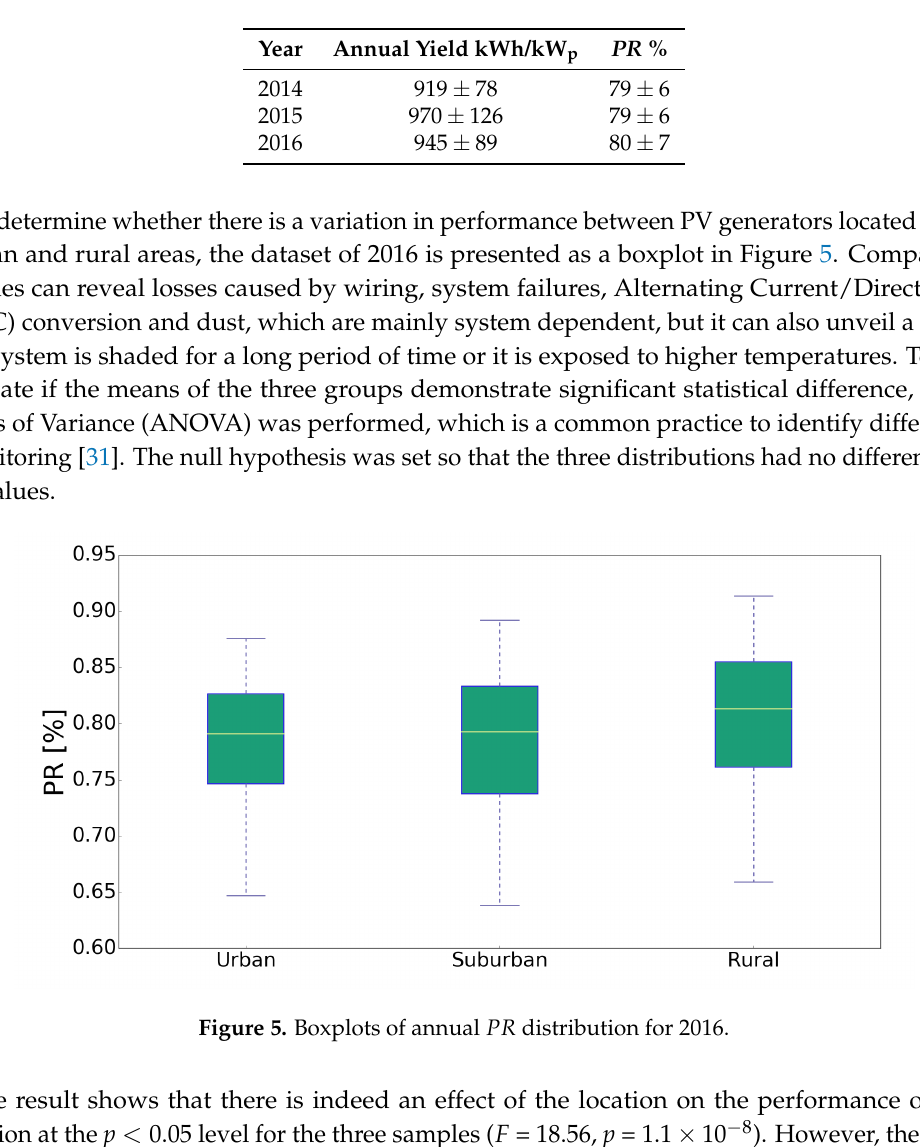
Table 1. Average annual yield and PR values with the corresponding standard deviations